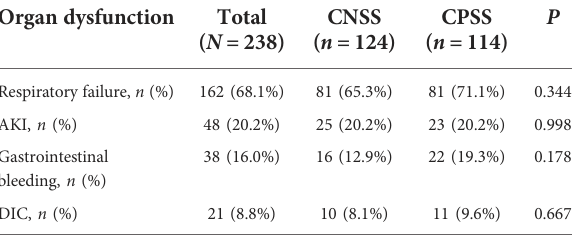
TABLE 3 Organ dysfunction of CNSS group and CPSS